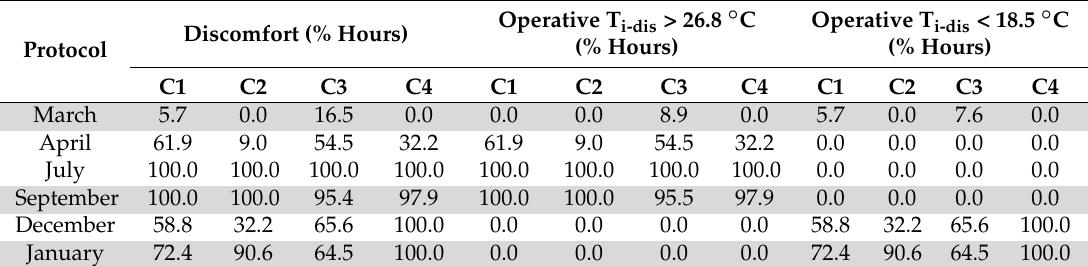
Table 4. Percentage of hours in discomfort for each cell and protocol